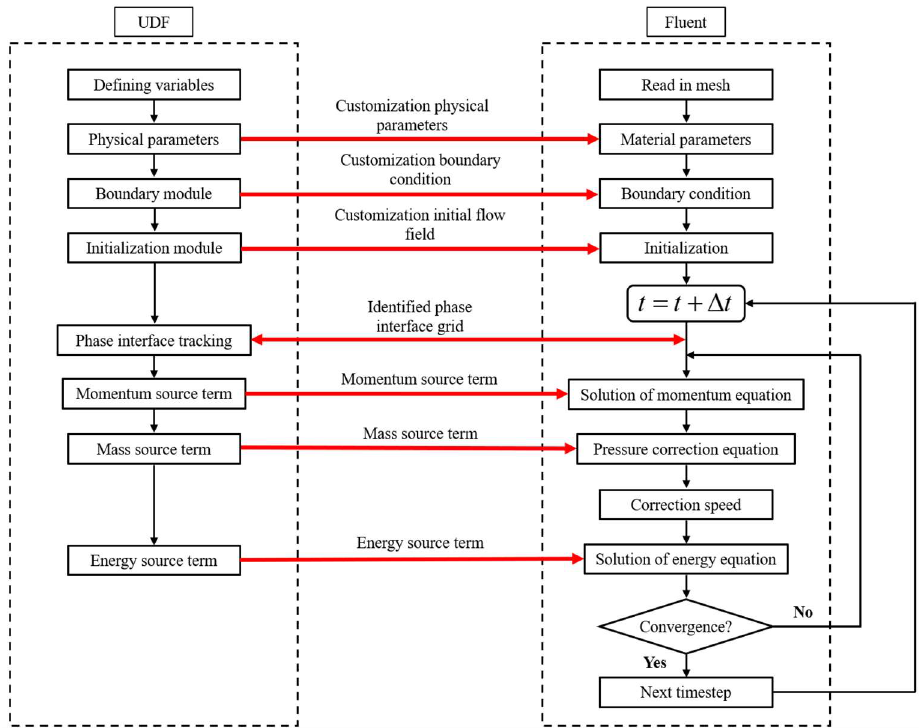
Figure 9. The schematic diagram of numerical method.